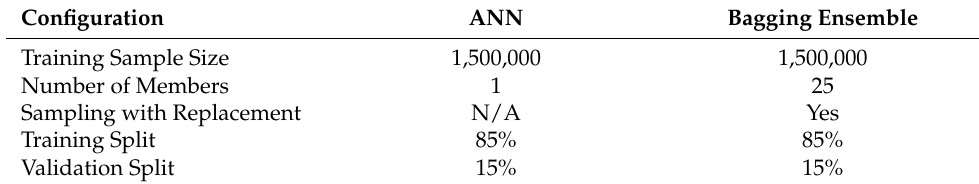
Table 2. Training and validation set